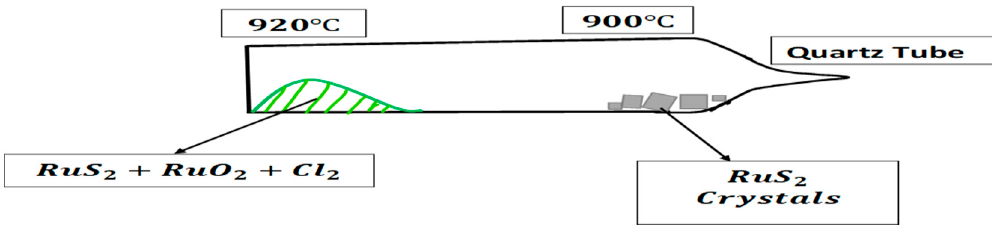
Figure 1. Growth of monocrystal of RuS 2 by CVT.